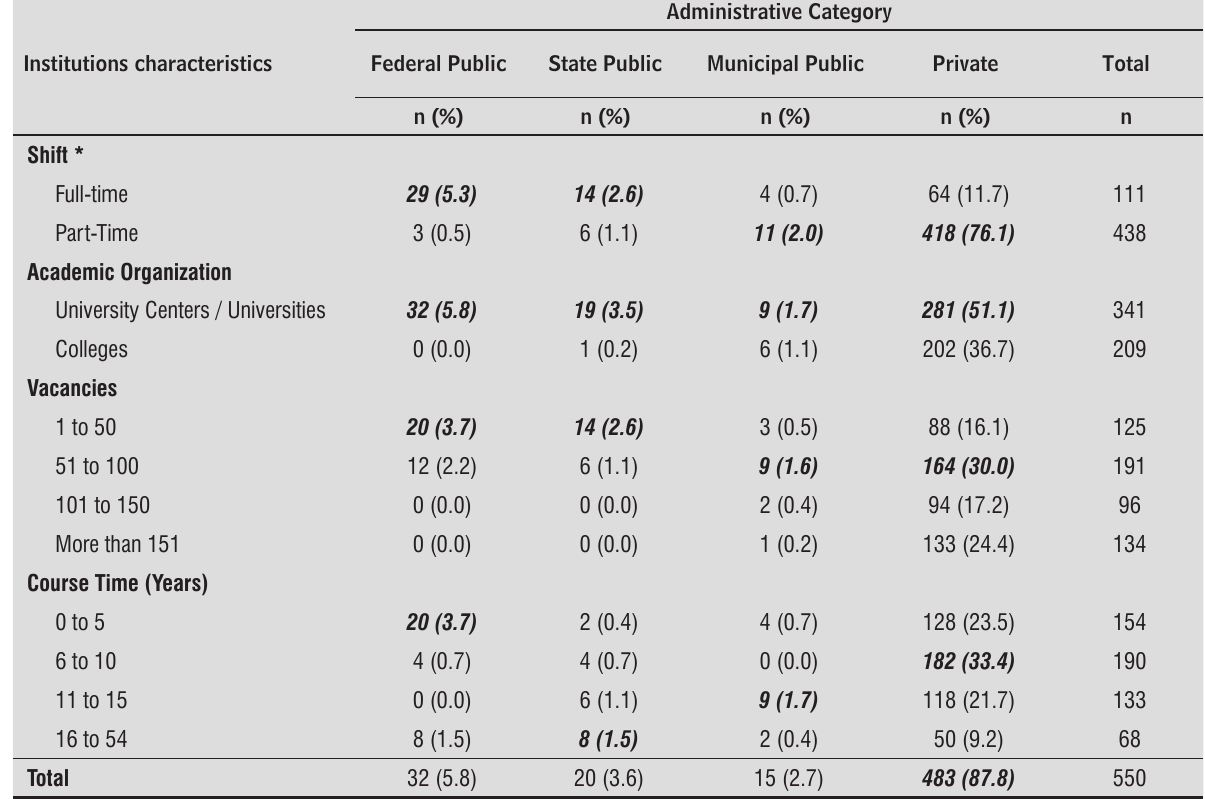
Table 4 - Distribution and percentage of Higher Education Institutions characteristics according to the administrative category